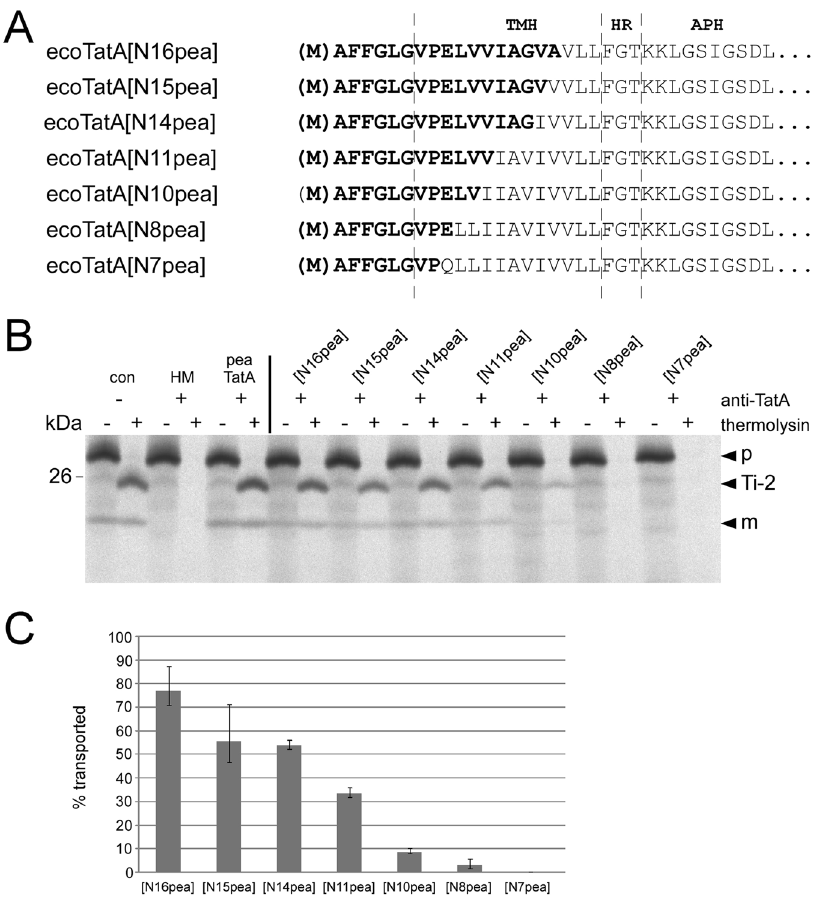
Figure 5. Catalytic activity of chimeric TatA proteins with substitution in the C-terminal part of the TMH region. ( A ) Amino acid sequence of the N-terminal regions of the chimeric TatA proteins analysed here. ( B ) In thylakoido complementation assays analysing the chimeric TatA proteins shown in ( A ). ( C) Quantitation of catalytic activities of three (n = 3) independent experiments as shown in ( B ) given as percentage of the